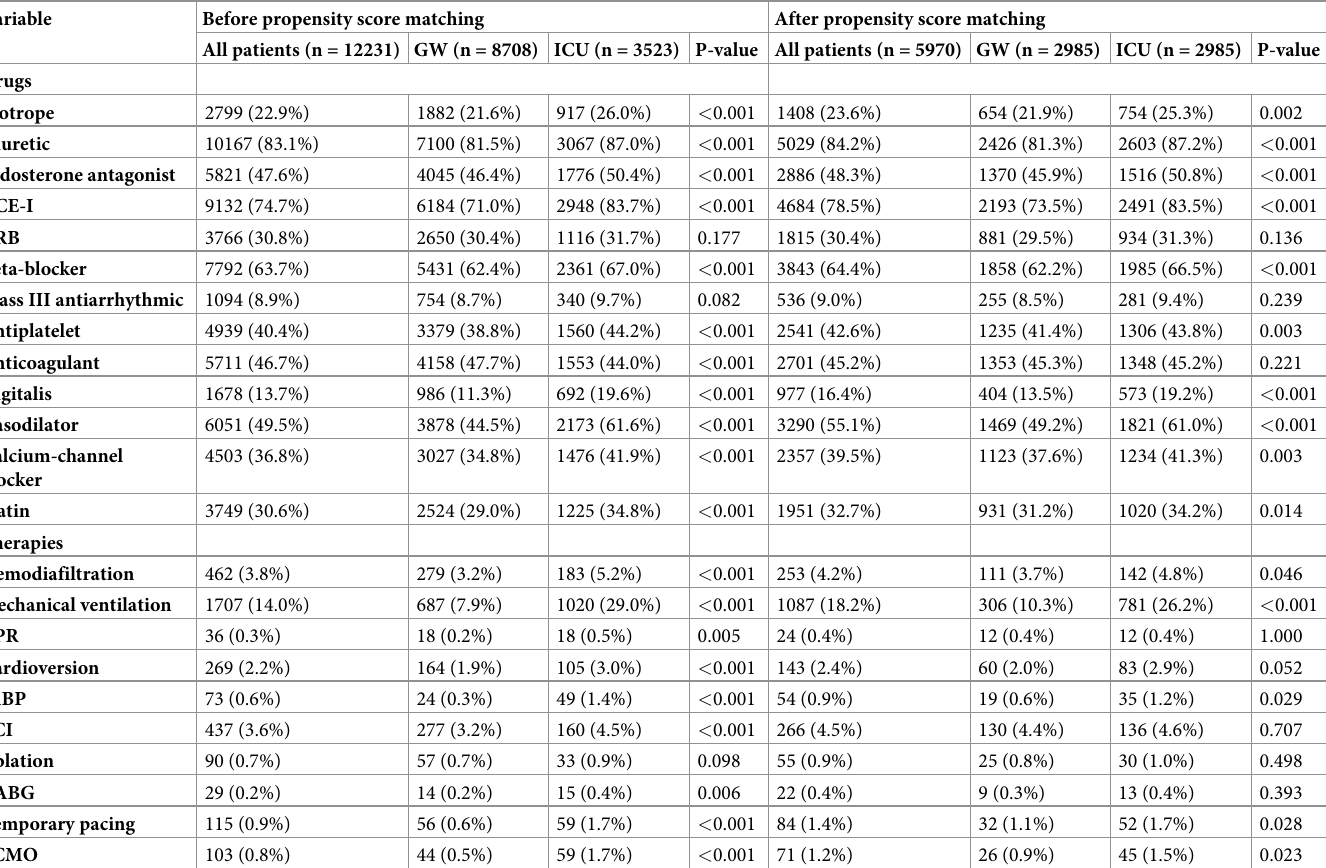
Table 2. Post-admission treatments in the pre-match and matched samples. Variable Before propensity score matching After propensity score